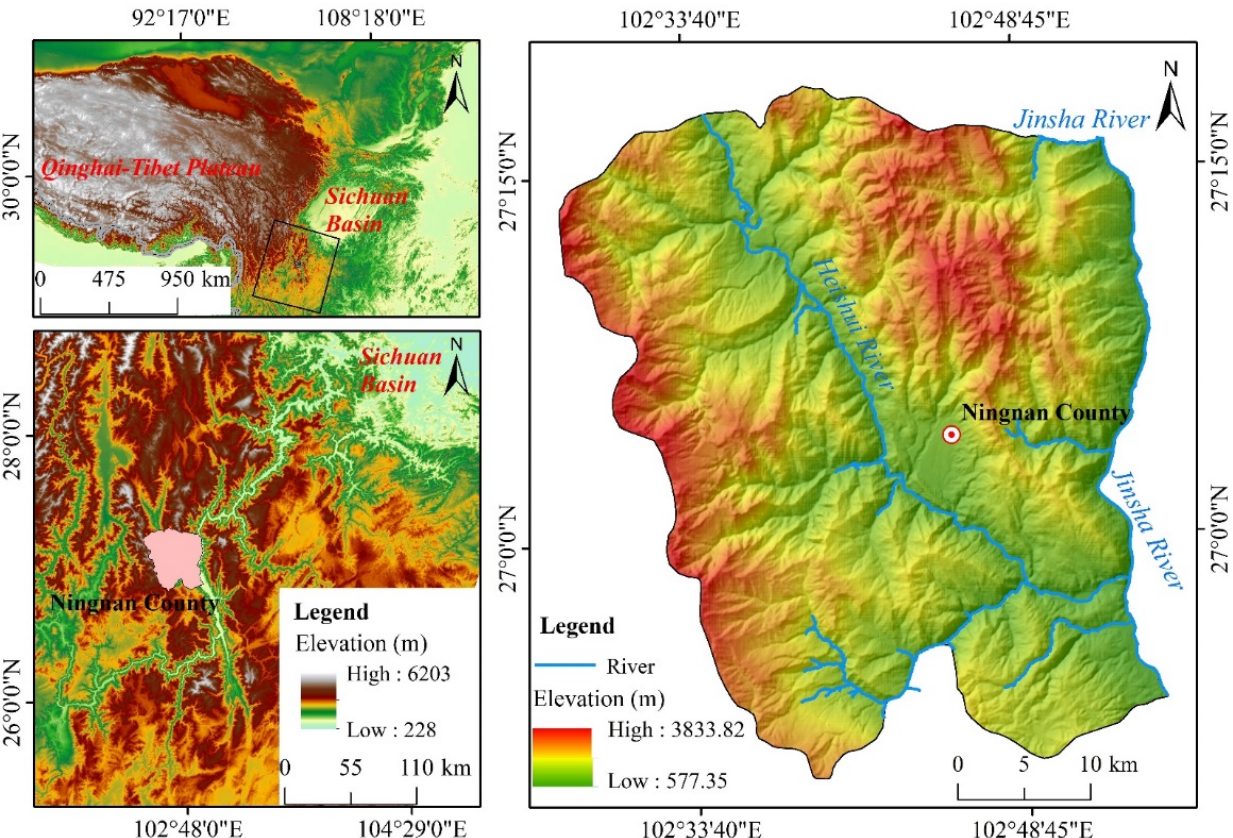
Figure 1. Location and elevation maps of the study area. Ningnan County is located on the southwestern edge of the Sichuan Basin in China, and its northwest region is the Qinghai–Tibet Plateau.